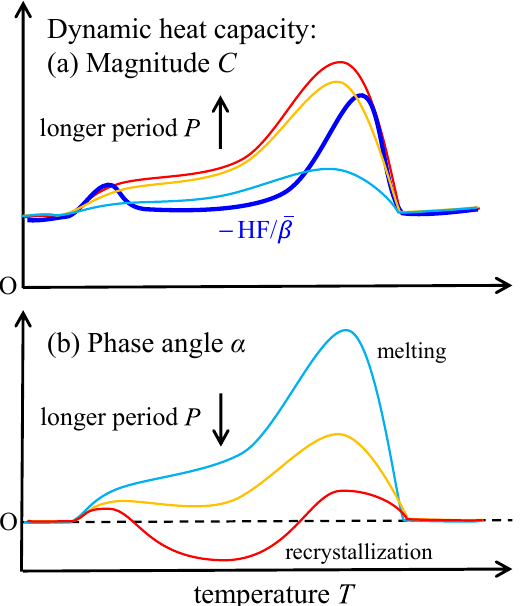
Figure 5. Schematic drawing of the behaviors of ( a ) magnitude and ( b ) phase angle in Figure 4.